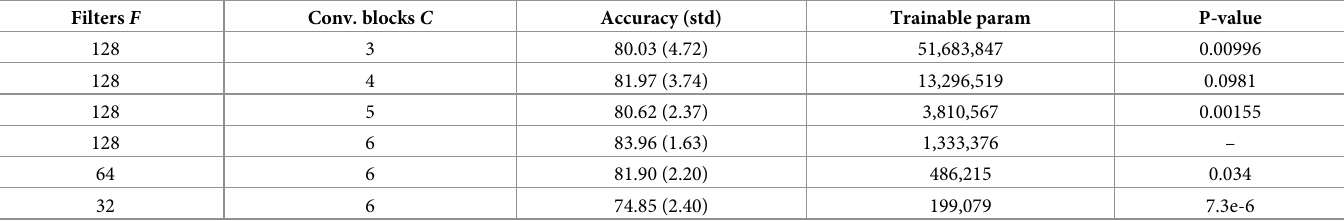
Table 3. Average accuracy and standard deviation (std) with their respective number of trainable parameters and p-values for different values of C and F across 20 runs with different random data partitions. P-values are calculated using 128 filters and 6 convolution blocks as the pivot. Filters